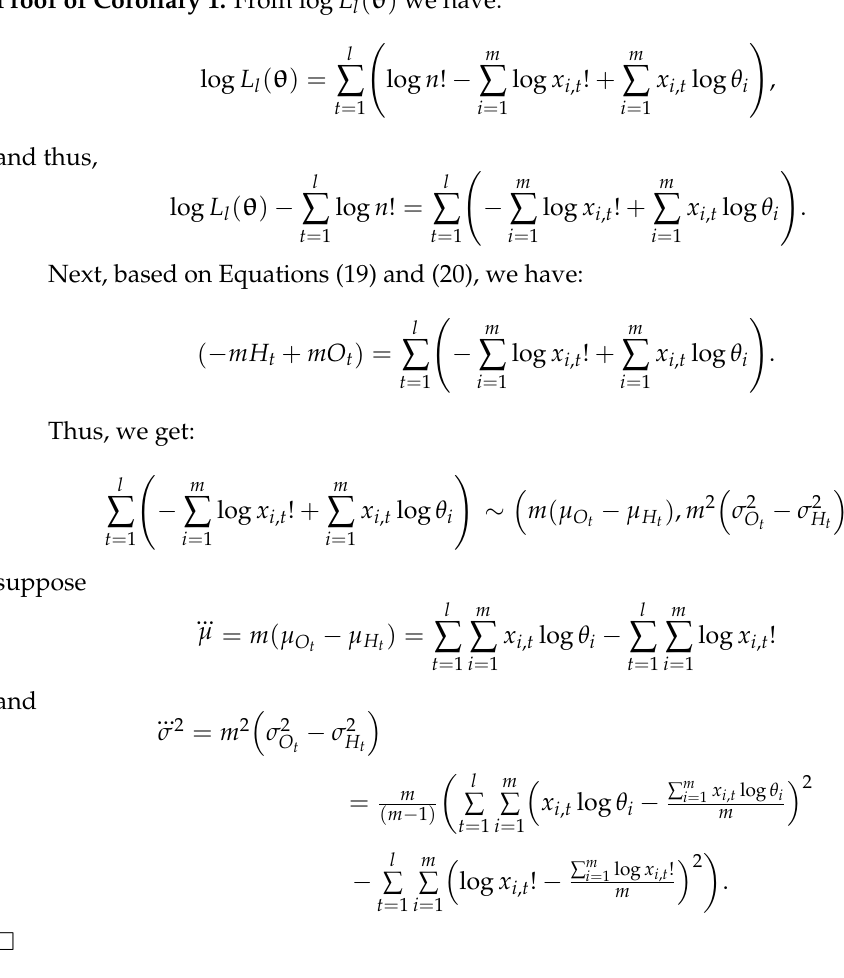
Figure 6. Histogram of values of log𝐿 (cid:3039) (θ) for 𝓀 = 1000 .